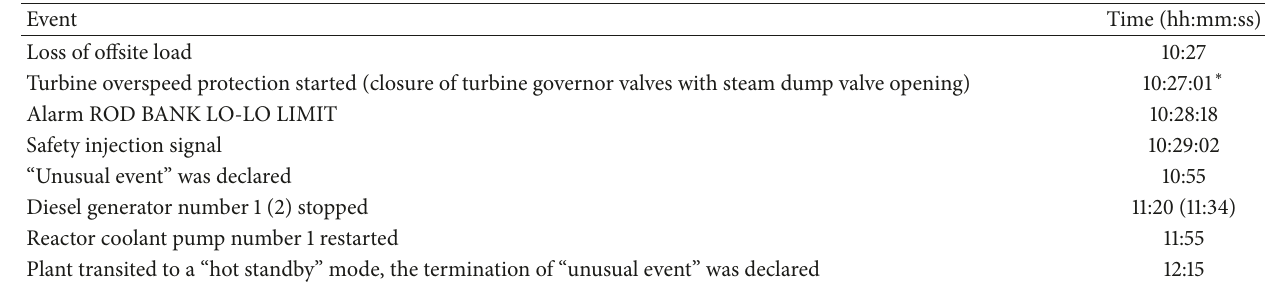
Table 1: Main sequence of events